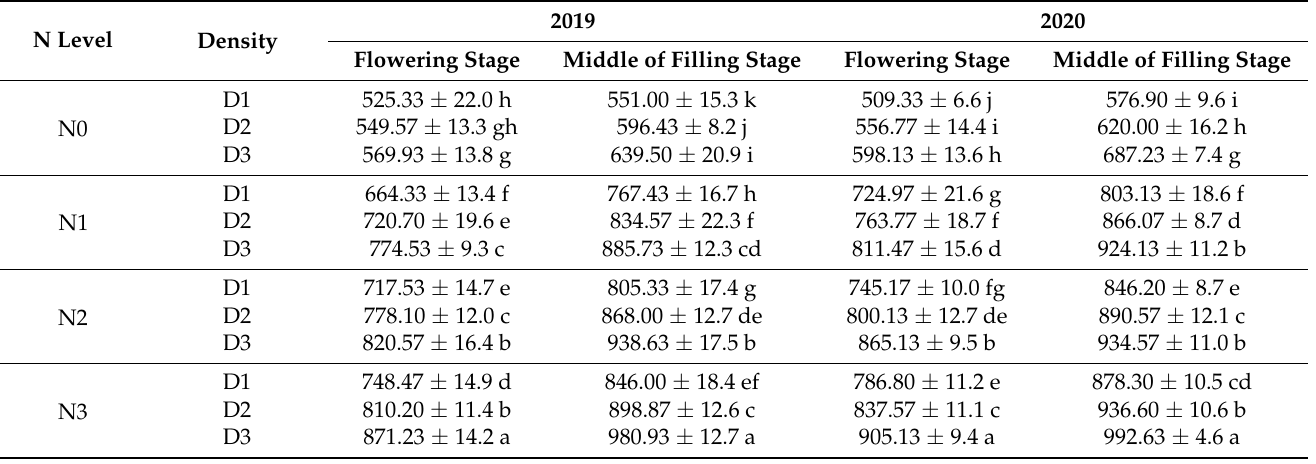
Note: Means ± SD followed by different letters in the same column indicated a significant difference ( p < 0.05). Four N fertilization levels—N0: 0 kg ha − 1 ; N1: 120 kg ha − 1 ; N2: 180 kg ha − 1 ; N3: 240 kg ha − 1 . Three plant densities—D1: 180 × 10 4 basic seedlings ha − 1 ; D2: